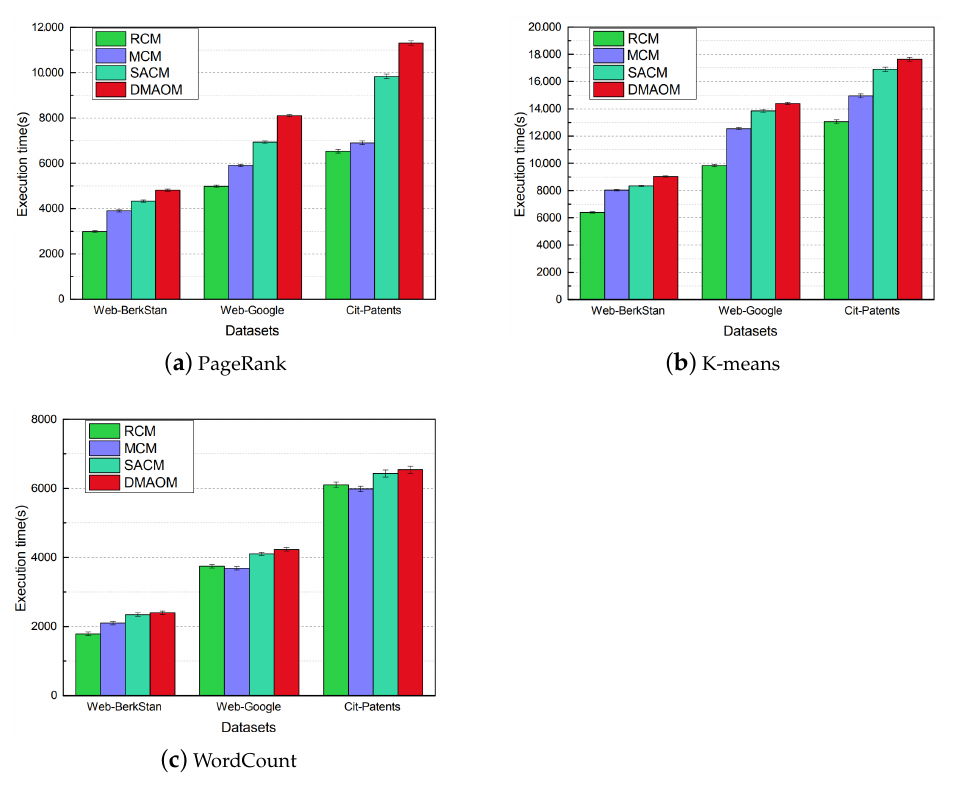
Figure 8. Job execution